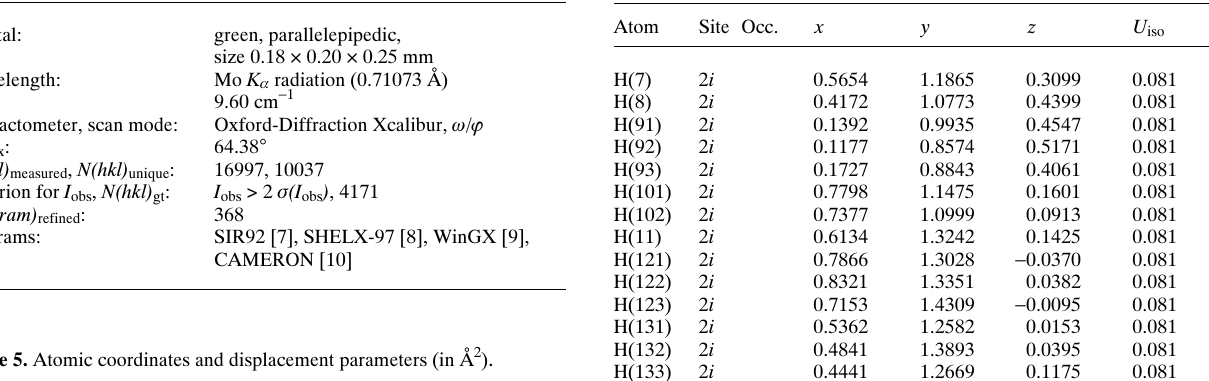
Table 4. Data collection and handling.